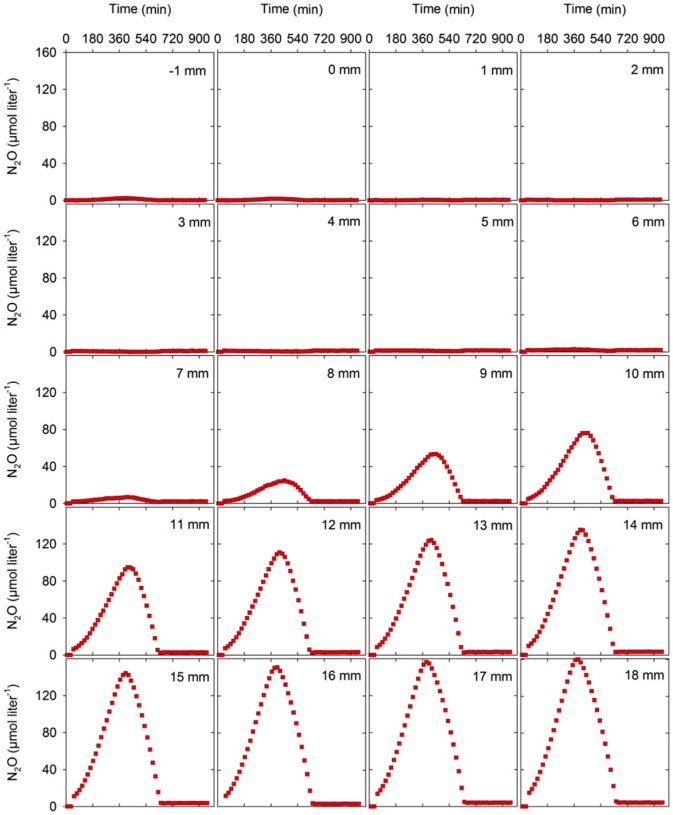
Rates of N2O production and consumption in sputum.Depth specific plots of N2O concentration vs. time at particular measuring depths in the same sputum sample as displayed in Fig 4. Accumulation and thus net production of N2O in all depths was observed until approximately 6 h, followed by net consumption of N2O presumably due to depletion of nitrate around 6 h.